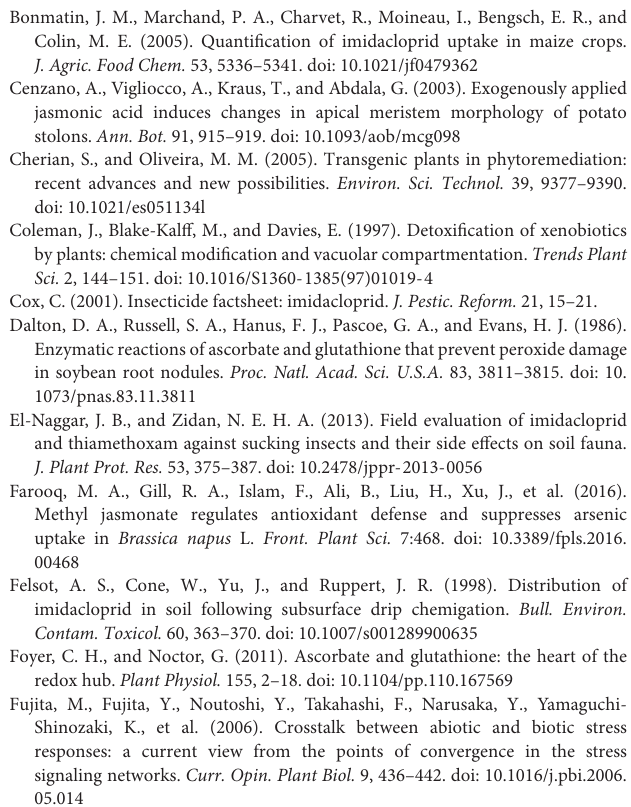
FIGURE S1 | Effect of JA seed soaking on growth parameters of B. juncea seedlings under IMI stress. Data shown here are mean ± S.D. Means with same letters are not significantly different from each other. CN = control, H1 = 1 nM JA, H2 = 100 nM JA, H3 = 200 nM JA, H4 = 300 nM JA, T1 = 200 mg · L − 1